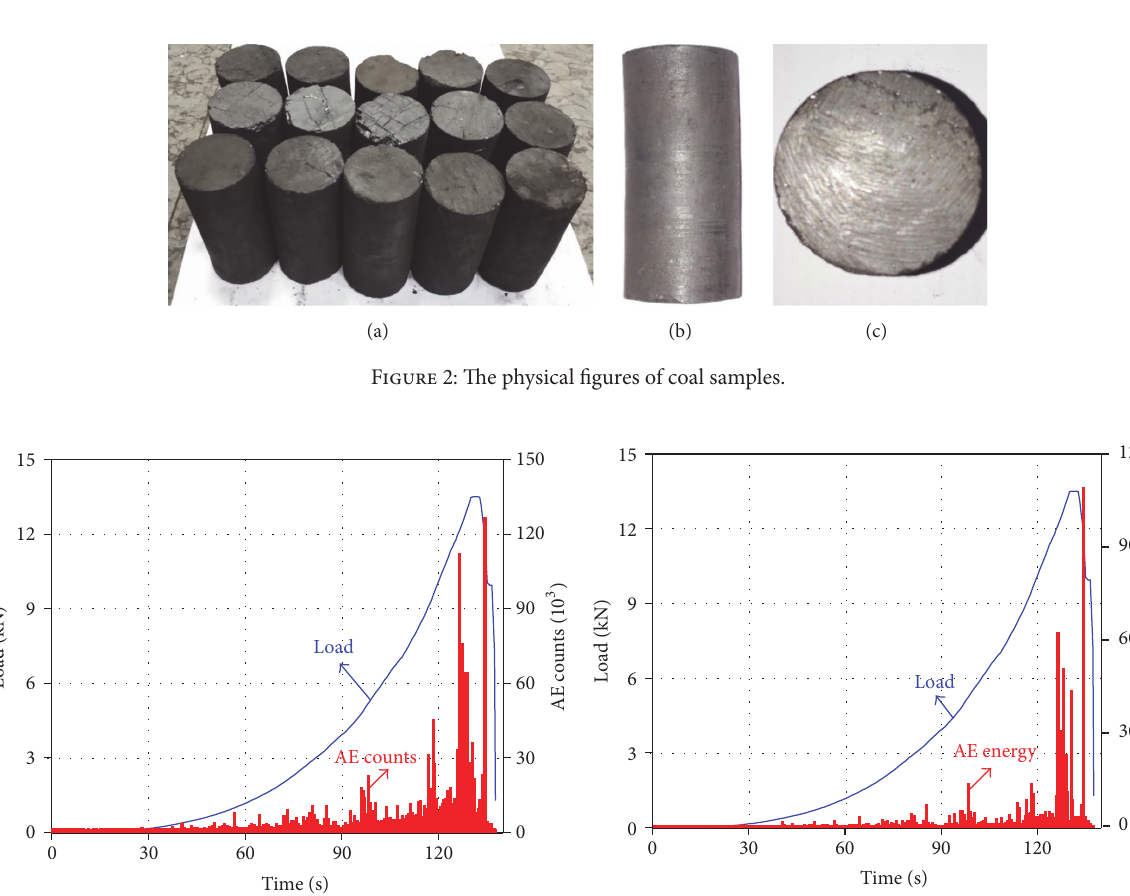
Figure 3: AE characteristics of coal samples under uniaxial